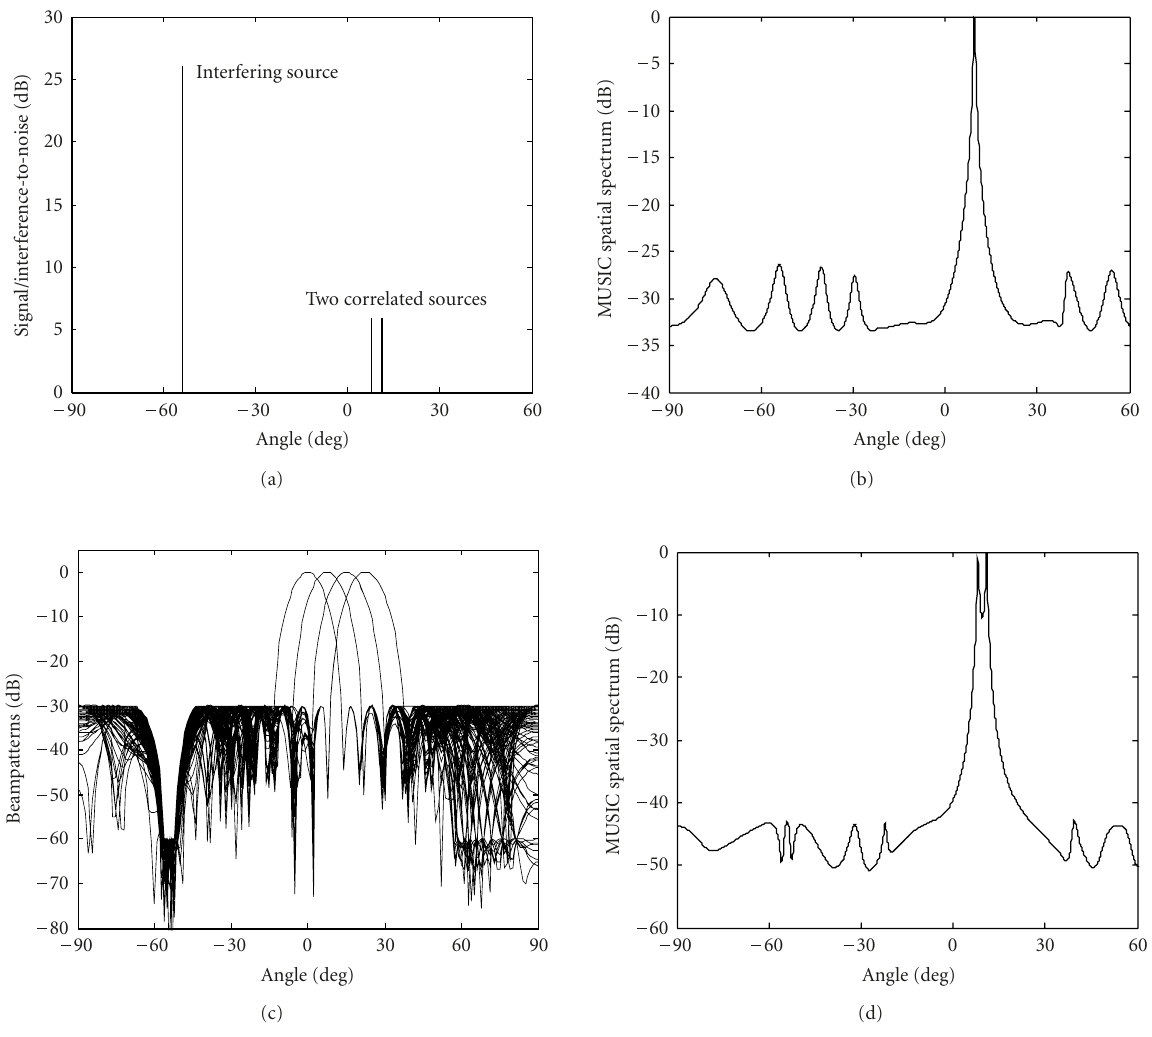
Figure 6: DOA estimation for the scenario of strong out-of-sector interfering source. (a) Directions of the two correlated sources and the interfering source. (b) DOA estimation result using the beamformers with uniform sidelobes. (c) Superposition of the notch beampatterns. (d) DOA estimation result using the notch